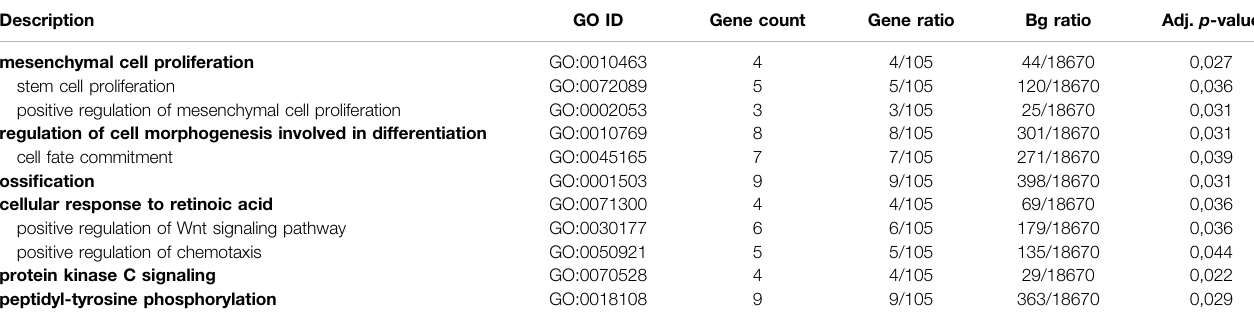
Gene count, number of differentially expressed (DE) genes associated with the GO term; gene ratio, associated genes/total DE genes; Bg ratio, number of associated genes/total background genes (all genes annotated in the Gene Ontology Consortium database); Adj p -value, false discovery rate-adjusted p -value.